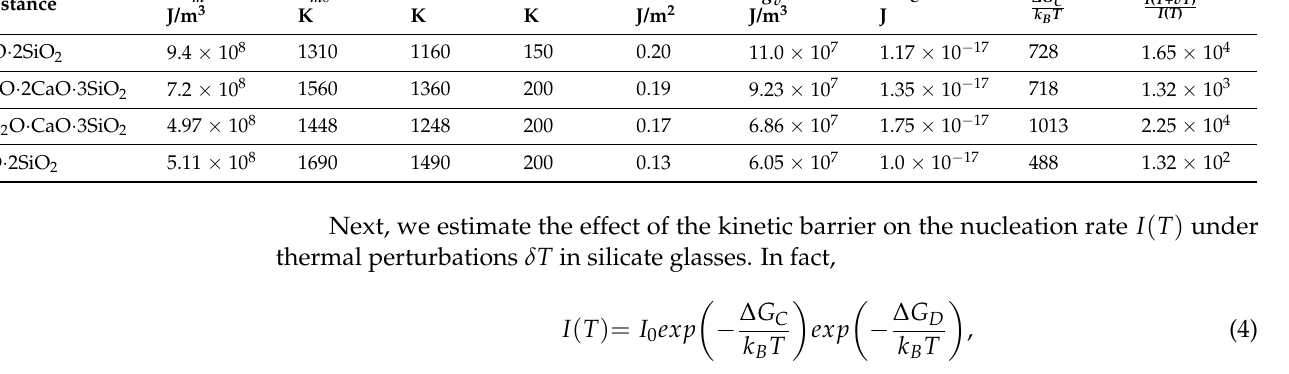
Table 1. Relative increase in the nucleation rate I ( T + δ T )